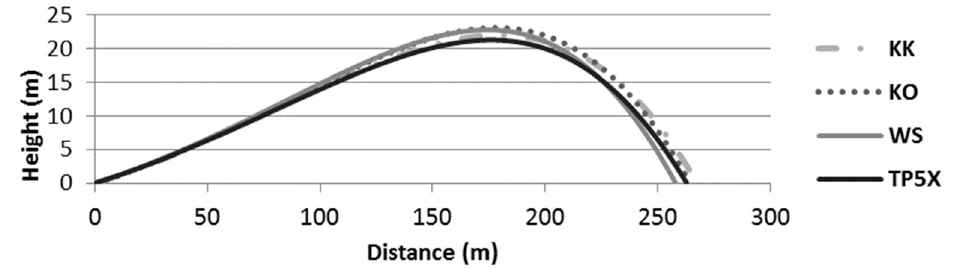
Figure 6. Trajectory simulation of 4 selected golf ball